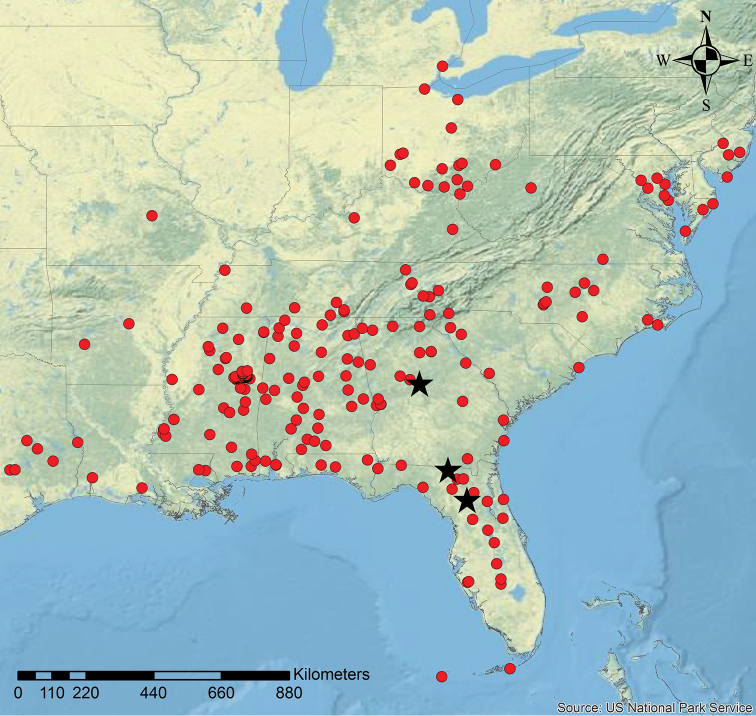
Geographic distribution of N.
parasitica (black stars) and its host N.
faisonensis (red circles). Host distribution data was supplemented with additional information from antmaps.org (Janicki et al. 2016).